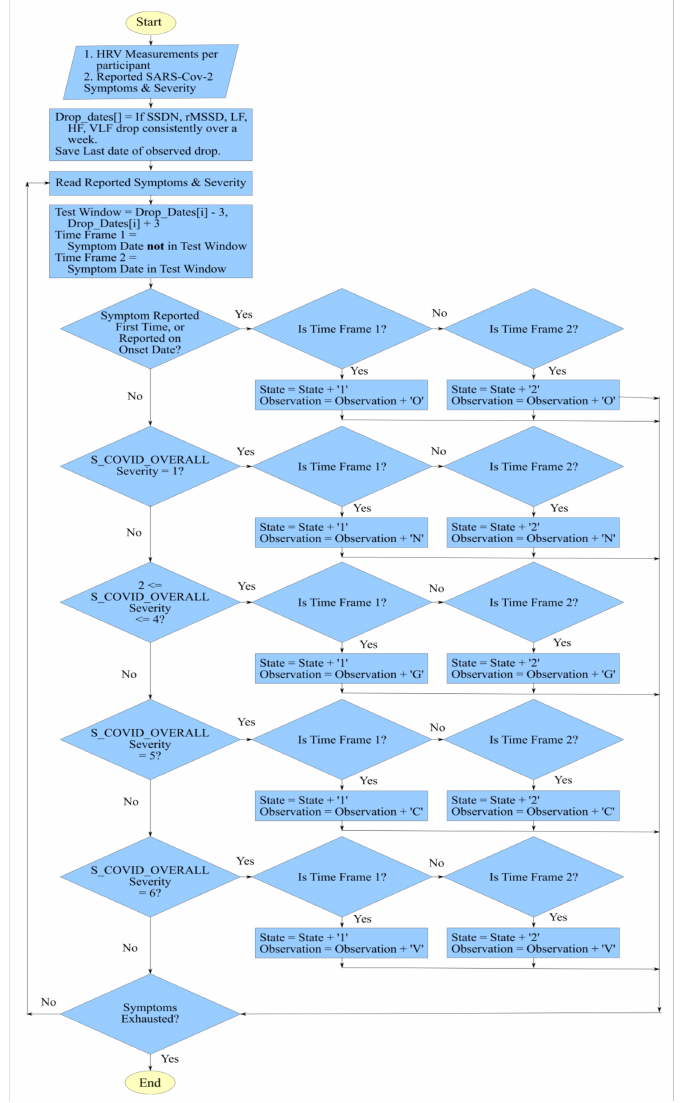
Figure 8. The flow of logic used to generate observations and hidden state sequences for